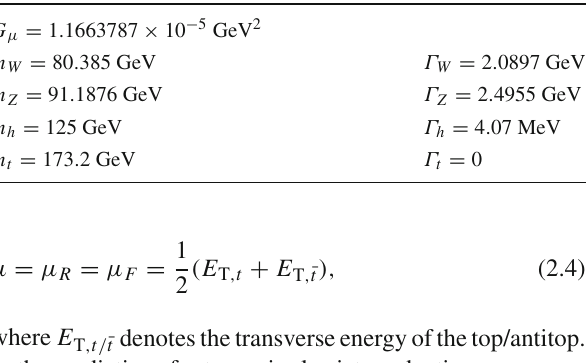
Table 1 Numerical values of input parameters. While the masses are taken from [88], the widths are obtained from state-of-the-art calcula-